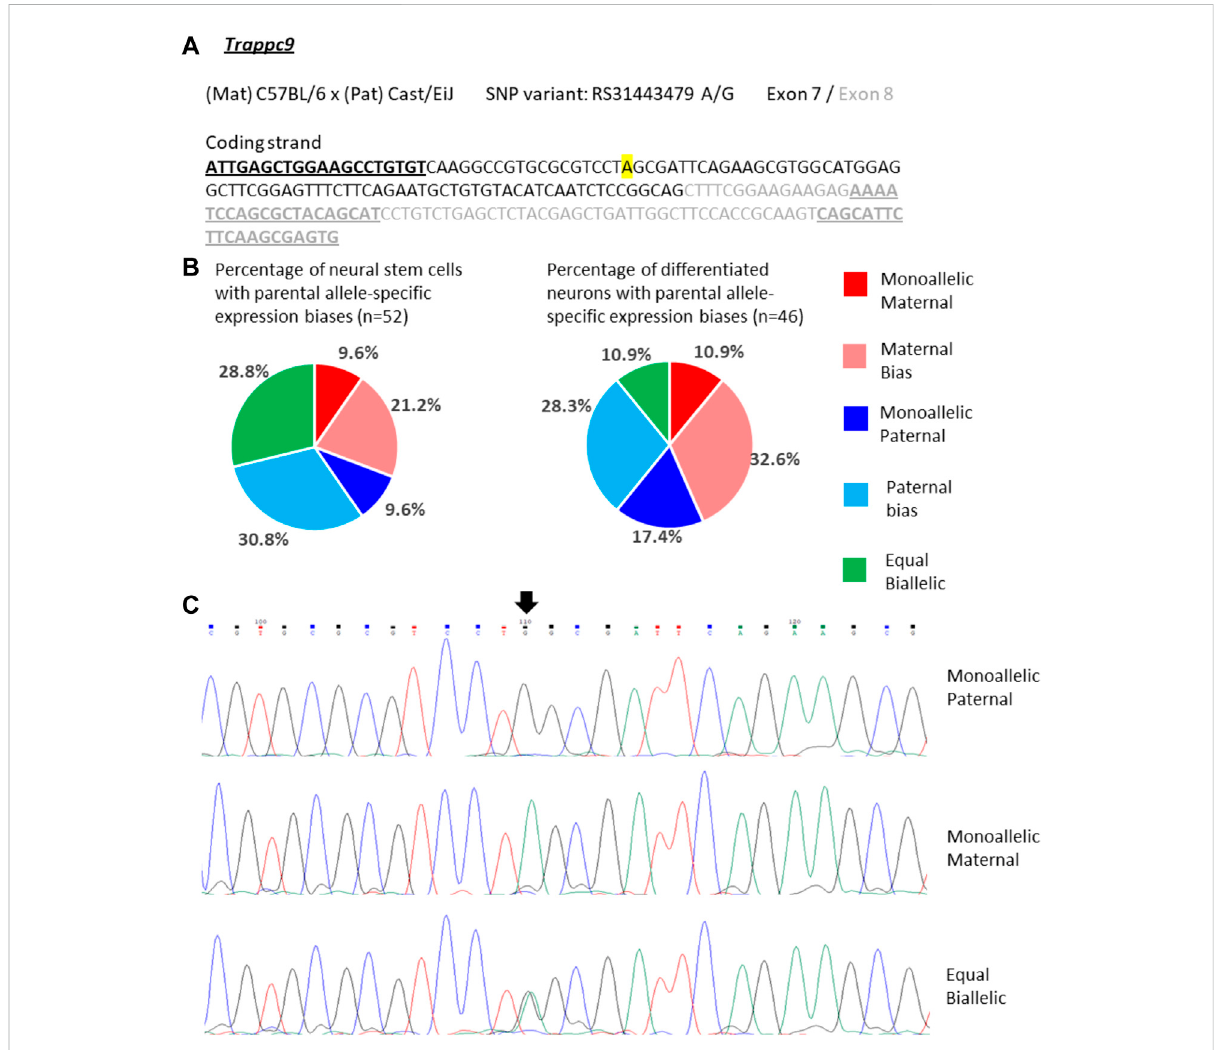
FIGURE 4 Variable single-cell allele-speci fi c expression of Trappc9 analyzed through Sanger sequencing of a cDNA SNP from neural stem (neurosphere) cellsandtheir invitro differentiatedneurons. (A) Themouse cross,cDNAampliconandSNP locationinexon 7areshown. B6SNP variantisindicated in color; primers are underlined. (B) Summary data showing the proportions of cells falling into the fi ve categories of allelic expression. (C) Example single-cell sequence tracks for the three expression categories indicated. Sequence tracks for cells with maternal or paternal bias displayed a major SNP peak for those alleles with a minor overlapping SNP peak for the other allele, respectively. SNP position is highlighted by an